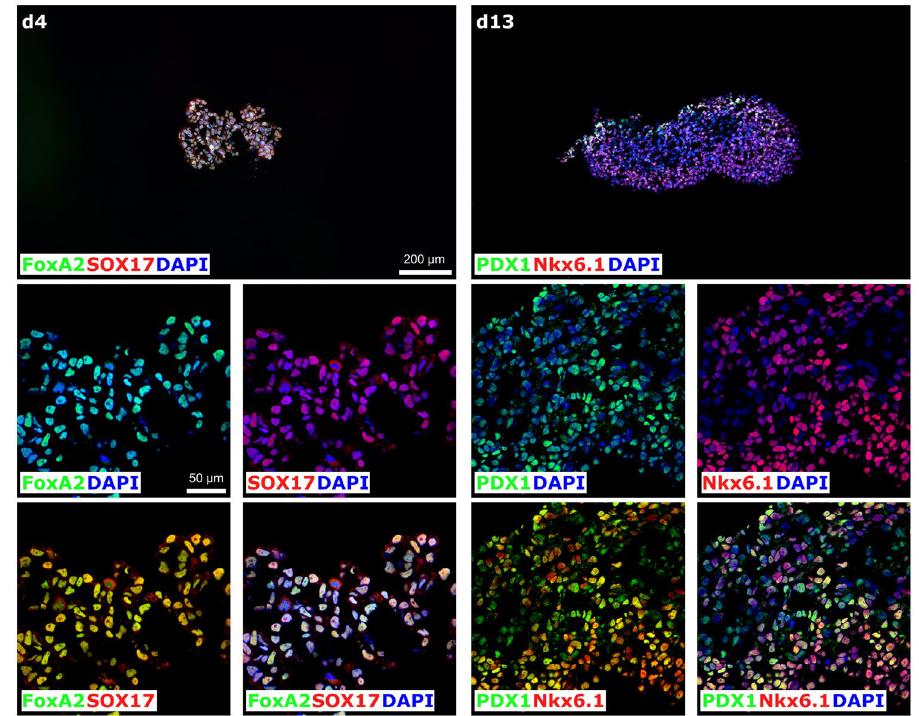
Figure 7. Immunocytochemical analysis of stage specific marker expression during pancreatic progenitor differentiation. SBAD2-iRFP720 reporter hiPSCs were differentiated in 3D culture system. Spheroids were fixed, cryosectioned, and the highest diameter middle sections were immunostained after 4 and 13 days of differentiation. Top panels represent the overview of the cryosectioned cultures, while the rest of the panels show higher magnifications on day 4 (left) or day 13 (right). On day 4, most of the cells express definitive endoderm markers FOXA2 (green) and SOX17 (red). Note the high expression of the key transcription factors in pancreatic cell development on day 13 (PDX1 in green, NKX6.1 in red). Nuclei were counterstained with DAPI (blue). Scale bars: 200 μm and 50